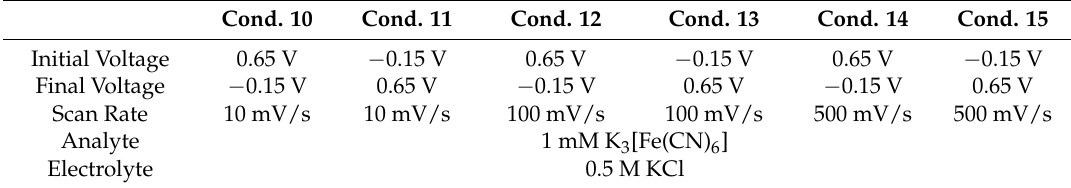
Table 5. LSV conditions for the